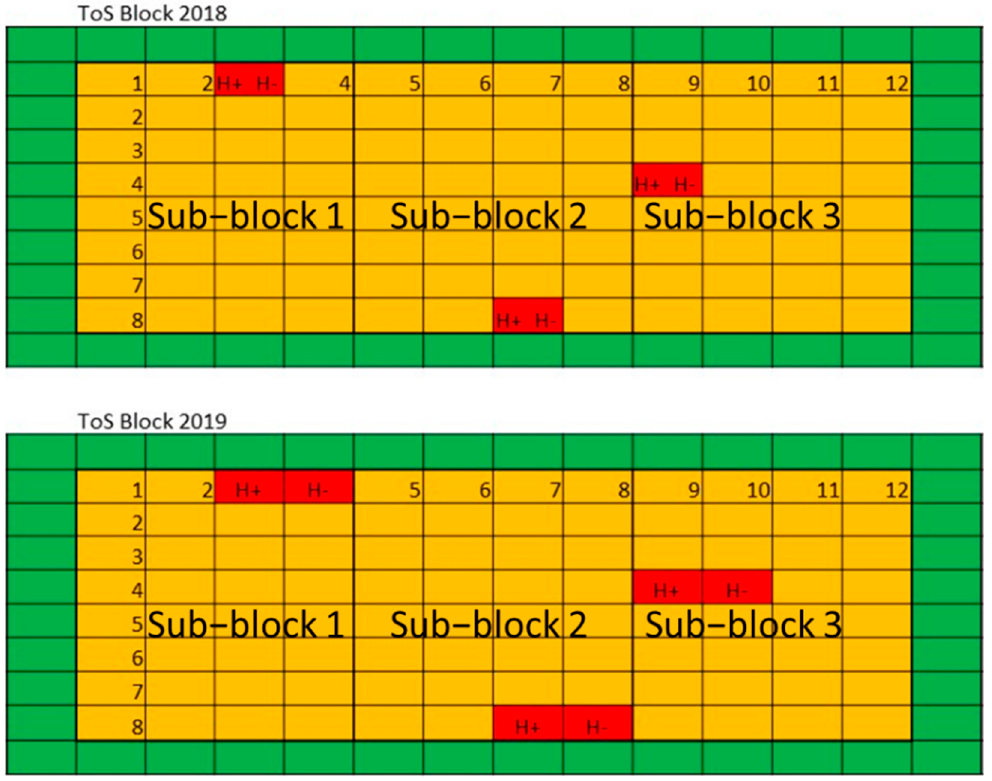
Figure 1. The field layout of the experiment displaying a model time of sowing (ToS) block from each year (2018 and 2019). Each ToS block contained three sub-blocks, with one plot replicate in each of these sub-blocks for all the 15 cultivars (two plots of each, including the heated and non-heated treatments for one cultivar, Wyalkatchem). Heated and non-heated treatments (red boxes) were located within each of the Wyalkatchem field plots within each sub-block. Buffer plots surrounded each ToS block (green boxes). Note that the location of heated and non-heated plots is not their actual location in the trials.